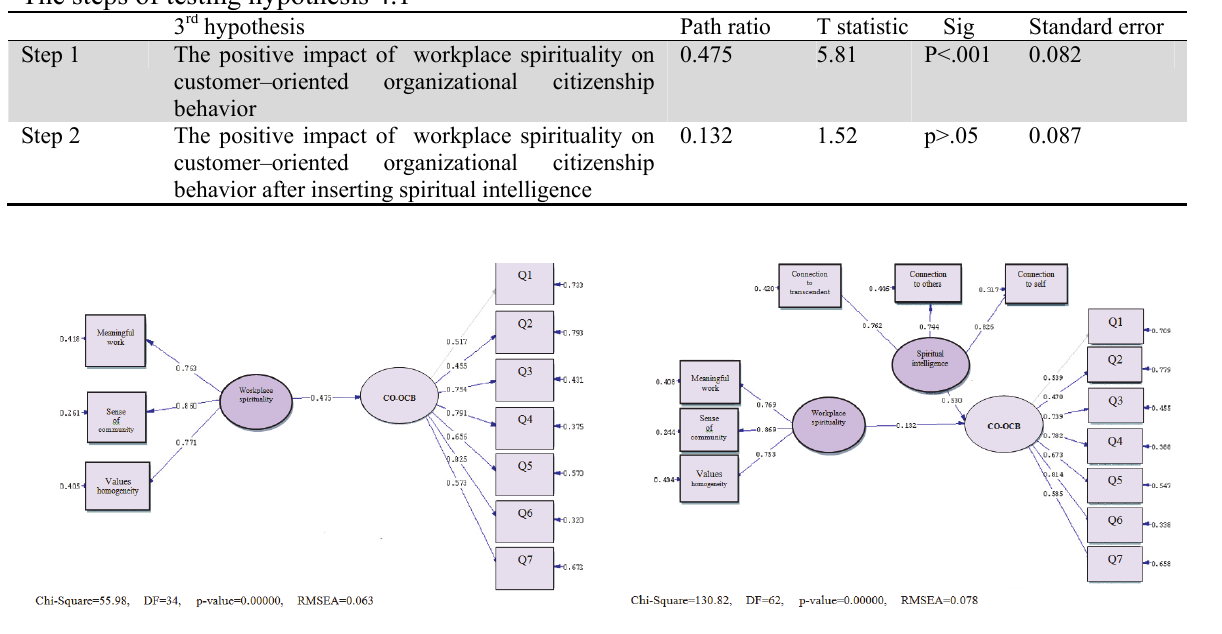
Fig. 5. The estimation model of the impact by “spirituality in work” on “customer – oriented organizational citizenship behavior”